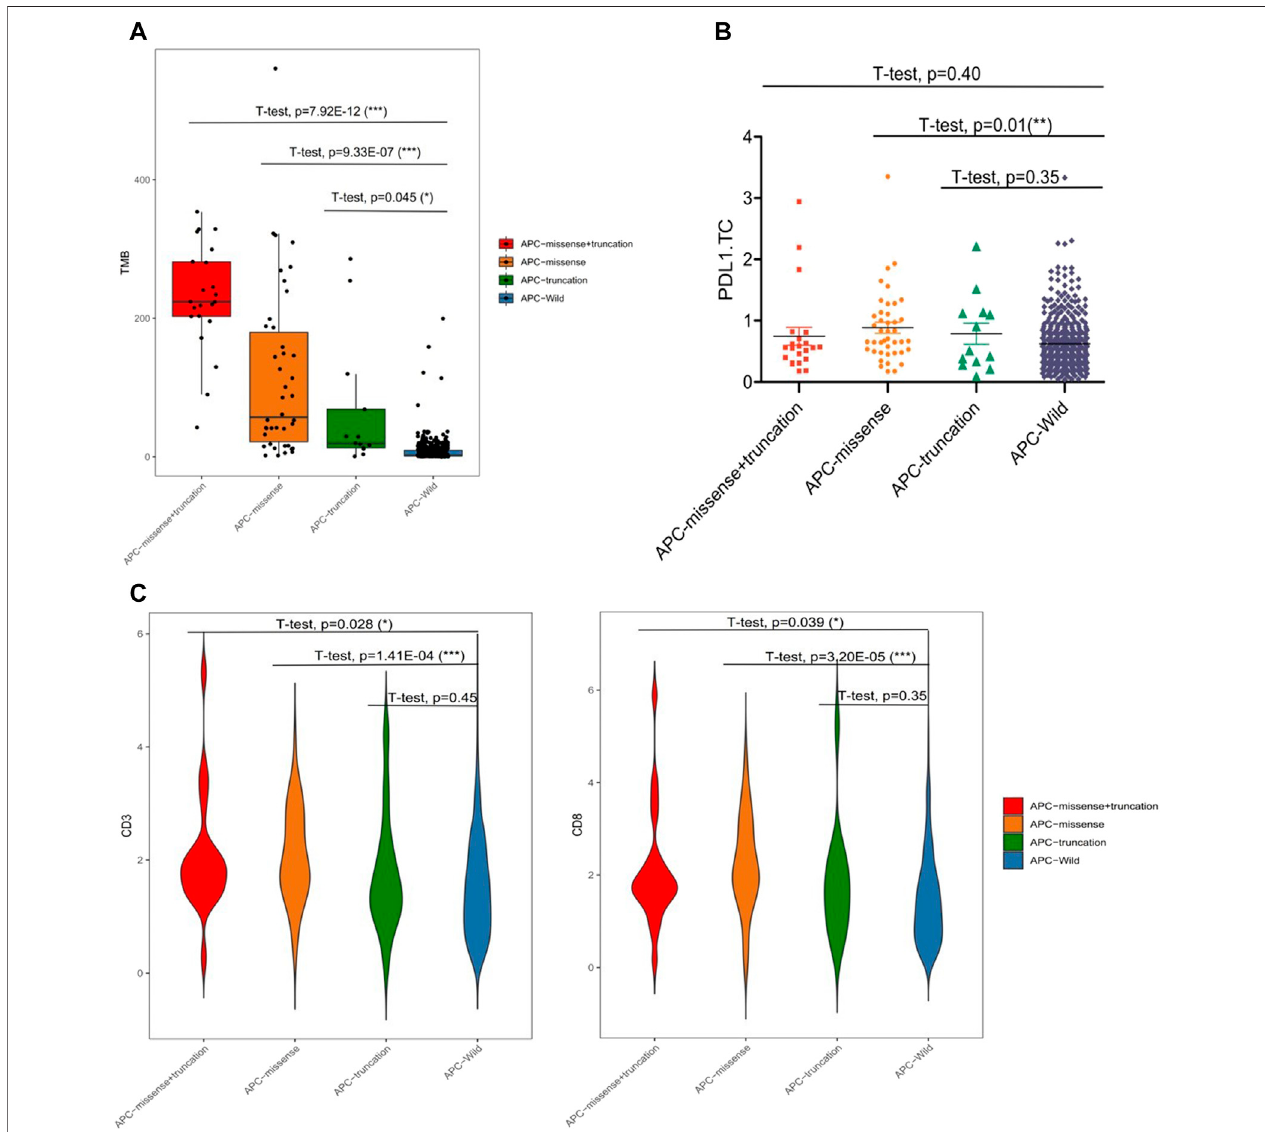
FIGURE 6 | Characteristic of APC mutation in the TCGA cohort. (A) Level of TMB in subtypes of APC. (B) PD-L1 expression in subtypes of APC. (C) CD3 + and CD8 + T cell in fi ltrations in the subtypes of APC.